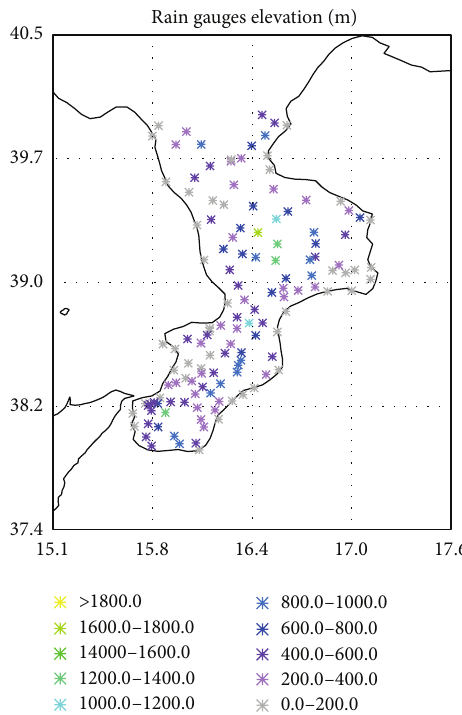
With the limitation of the small dataset available, the errors found over maritime areas are in line with those for the whole dataset for all parameters but the wind speed.